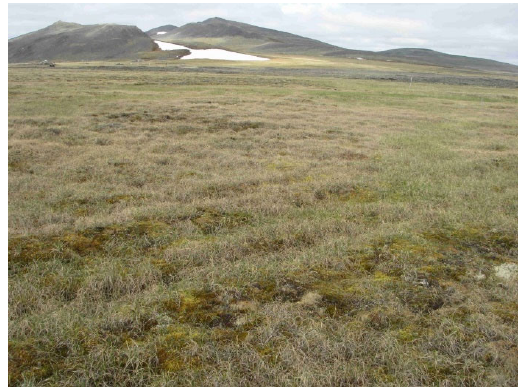
Figure 3. General view of monitoring site 2. Table 2. Grain-size distribution of the mineral soil, Site